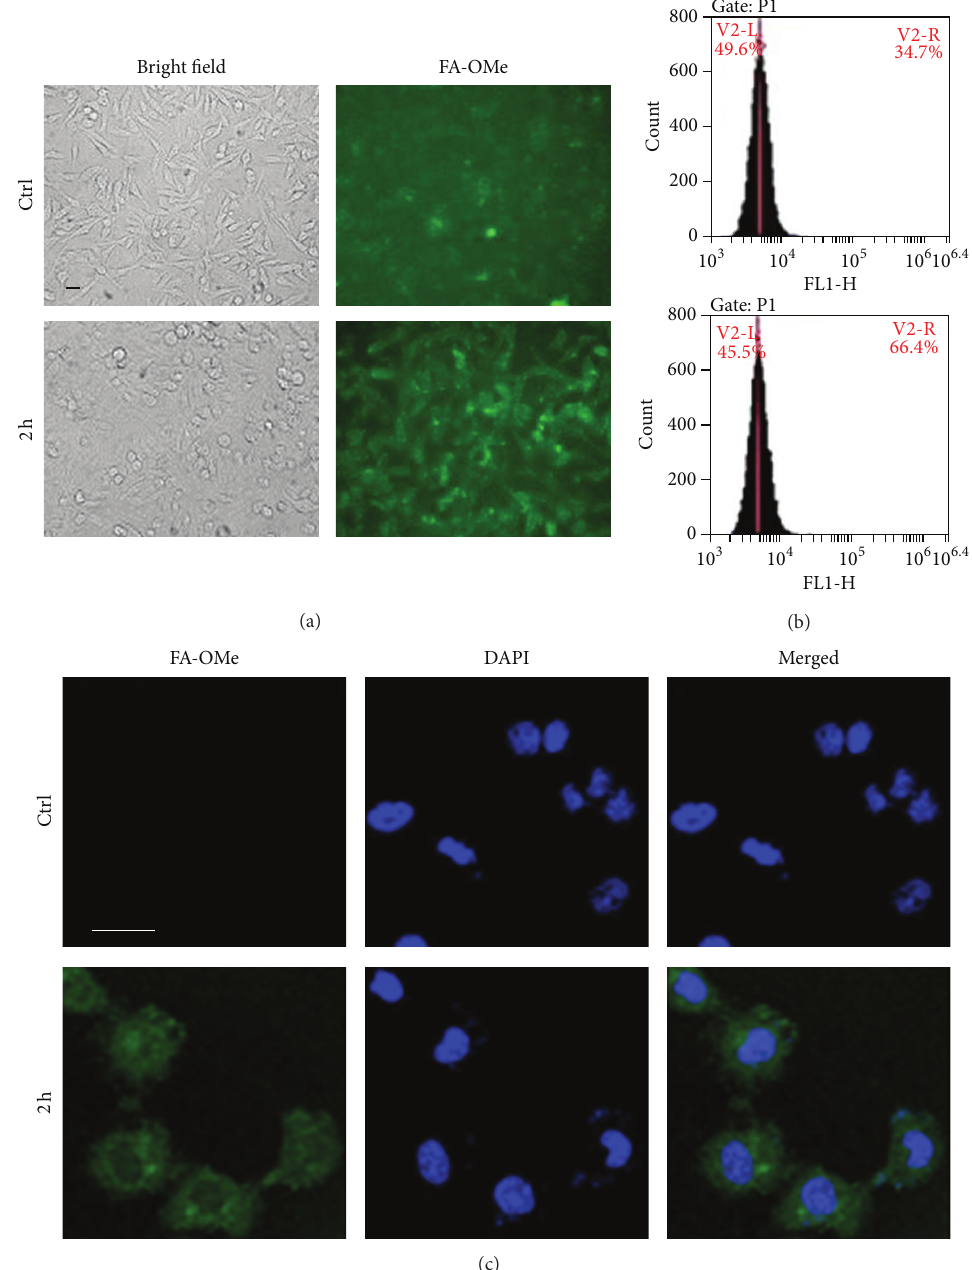
Figure 2: Elevated NO levels monitored by specific fluorescent probes. (a) ECs treated with NaHS (50 𝜇 M) for 2h stained by FA-OMe and observed by fluorescent microscopy. (b) FA-OMe signals calculated by flow cytometry. (c) FA-OMe signals observed by confocal microscopy. Bar = 20 𝜇